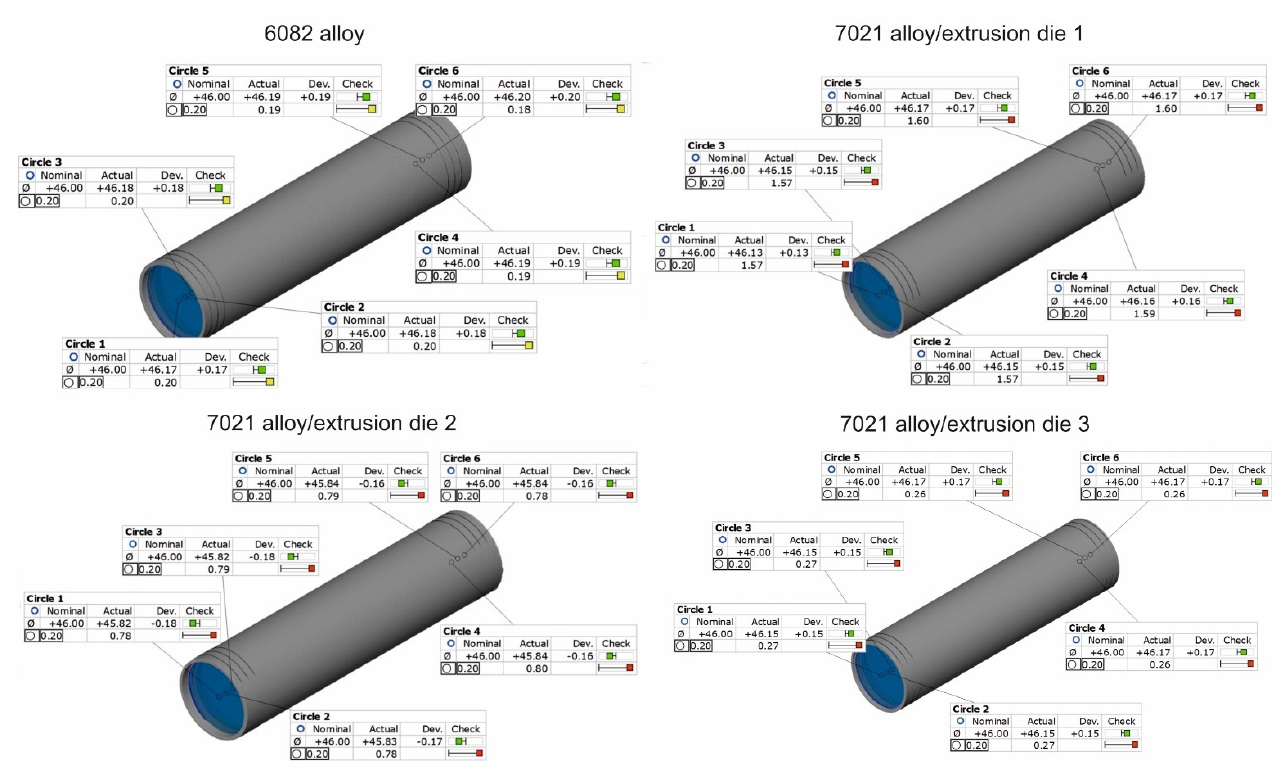
Figure 17. Results of optical scanning of the tubes of Ø50 × 2 mm: measured inner diameter and roundness deviations of tubes extruded from 6082 alloy by using 4-hole die (on the top left) and extruded from 7021 alloy by using 2-hole die 1 (on the top right), 2-hole die 2 (on the bottom left), as well as extruded from 7021 alloy by using 2-hole die 3 (on the bottom right).